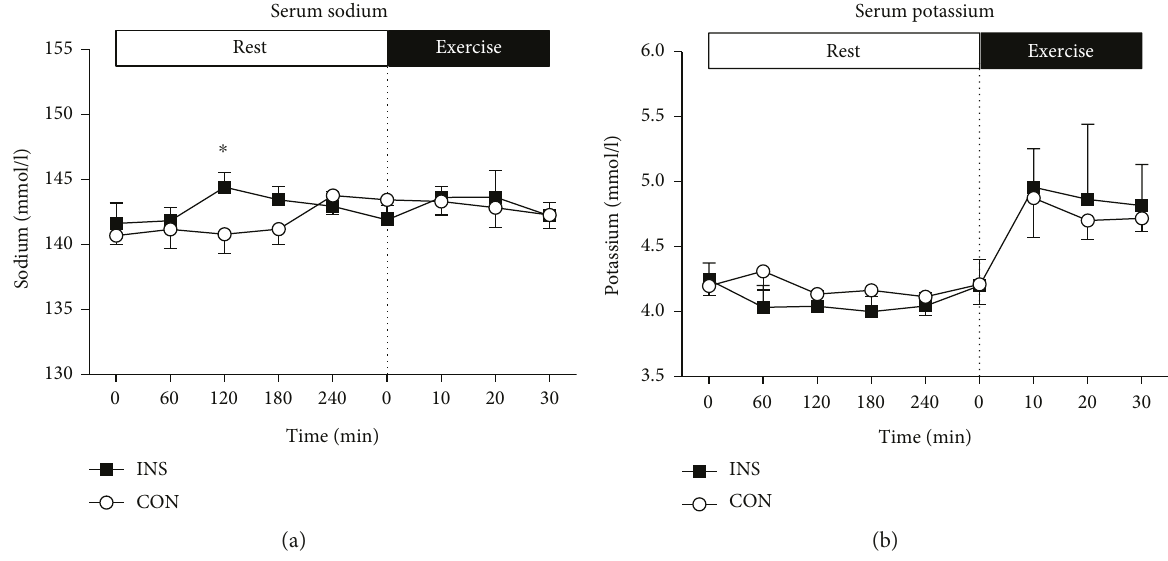
Figure 3: Serum sodium (a) and potassium (b) concentrations during the INS and CON trials. Data represent n = 6 , mean ± SEM. (a) At rest, the infusion signi fi cantly increased serum sodium in INS compared to that in CON ( P < 0 05 ) but there were no signi fi cant interaction or time e ff ects. During exercise, there were no signi fi cant main e ff ects for infusion, time, or interaction. (b) At rest, there was a trend ( P = 0 060 ) for lower potassium in INS than in CON and a trend ( P = 0 063 ) for time e ff ect. During exercise, there was a signi fi cant increase in serum potassium (time e ff ect P < 0 05 ) but there were no signi fi cant di ff erences between INS and CON. ∗ P < 0 05 from